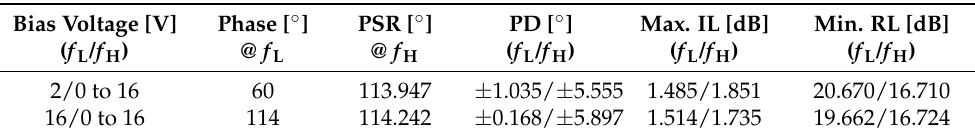
while fixing the bias voltage of the